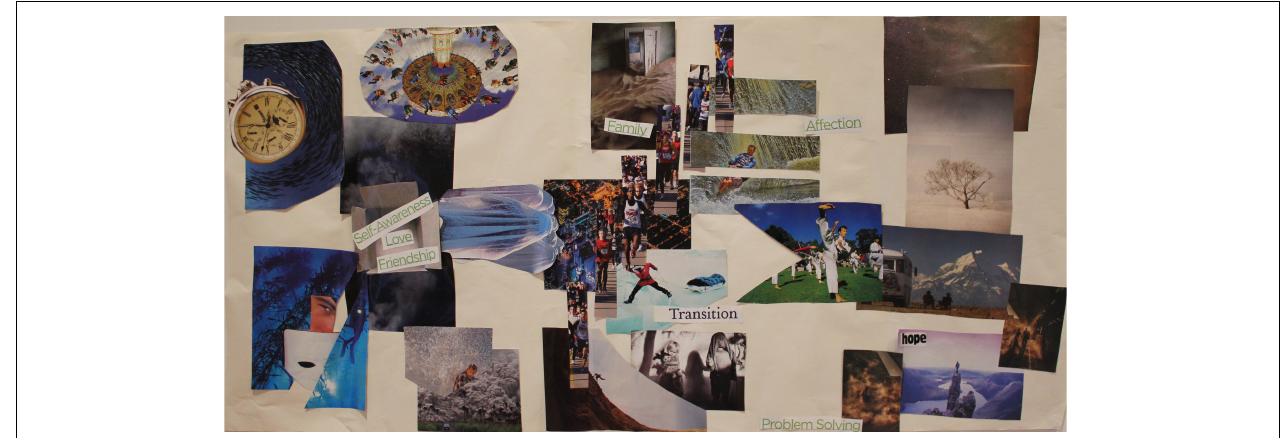
FIGURE 3 | Participant artwork: “Holding out for